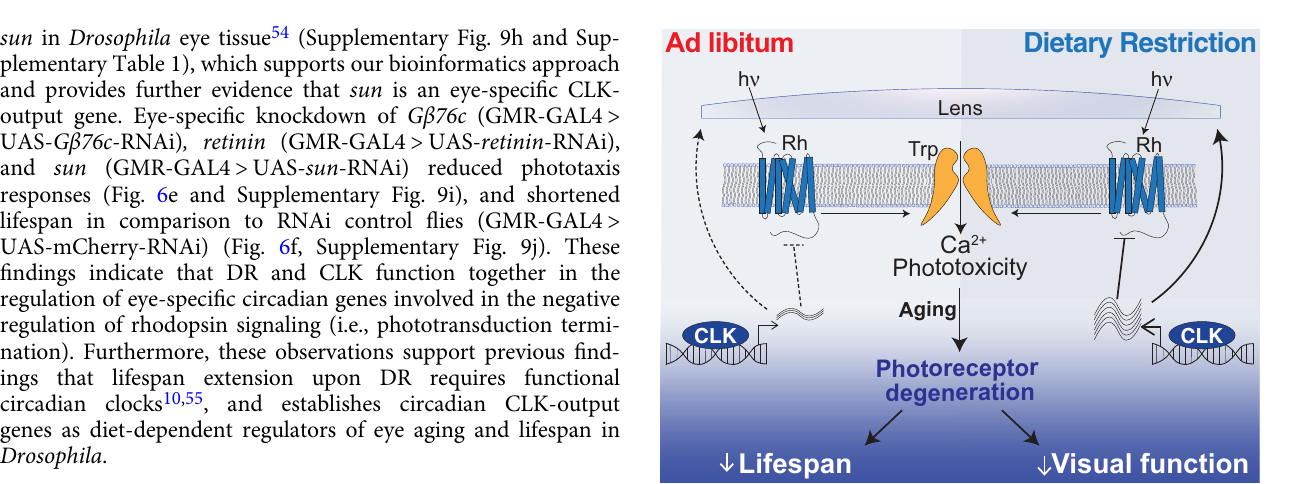
Fig. 7 Dietary restriction extends lifespan by promoting rhythmic homeostatic processes in the eye. DR promotes CLK-output processes in the eye that suppress light/Ca 2 + -mediated phototoxicity to delay visual senescence and improve